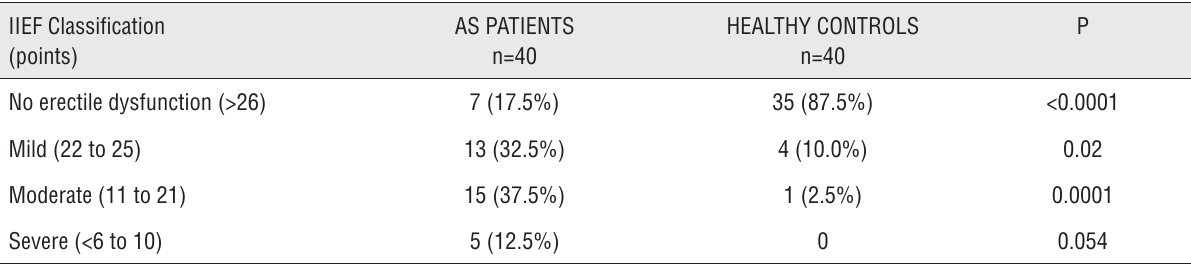
Table 3 - International Index of Erectile function (IIEf) scores in patients with Ankylosing spondylitis (As) and healthy controls